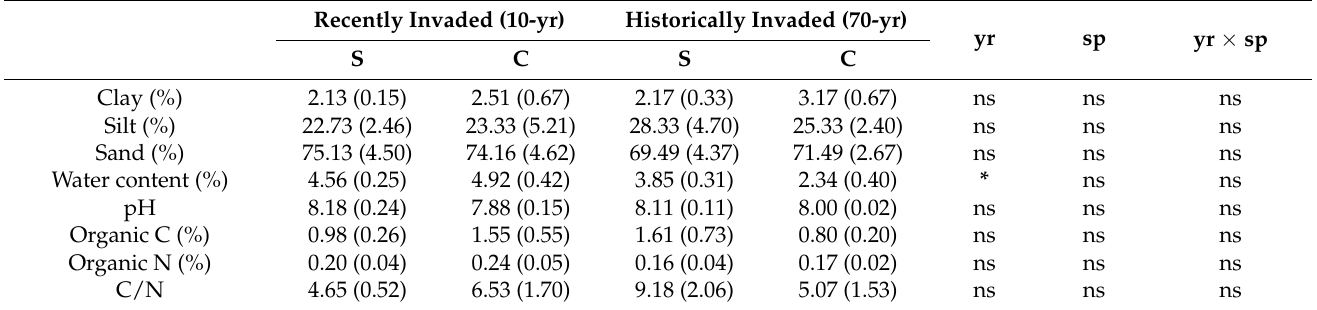
Table 1. Soil physicochemical properties (mean ± SE) in the rhizospheres of the alien Solanum elaeagnifolium (S) and the native Cichorium intybus (C) in recently and historically invaded sites. PERMANONA results for the effects of factors “year”, “species” and their interaction are shown (ns: non-significant. *: p <